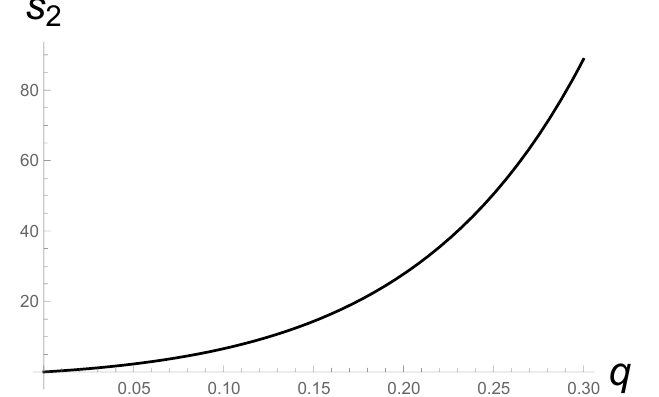
Figure 4 . Plot of s 2 as a function of q for s 1 ( q ) which saturates the (cid:12)rst constraint of (7.6), i.e. along the blue curve in (cid:12)gure 2. For all q > 0, s 2 is positive, and s 2 = 0 only for q = 0. It means that s 2 (cid:21) 0 in the allowed region in (cid:12)gure